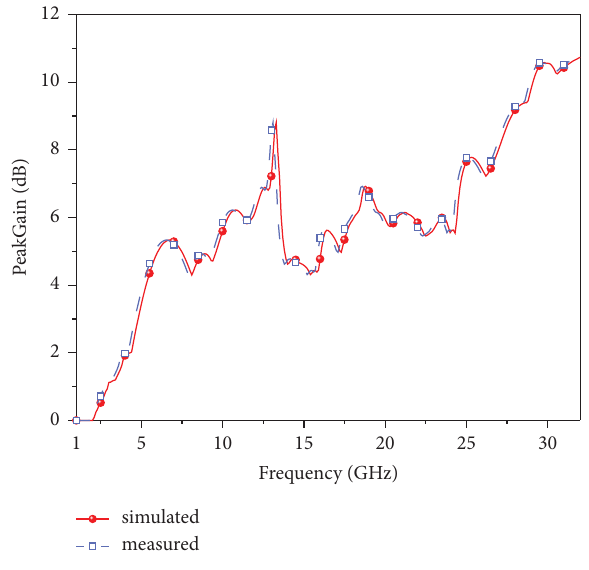
Figure 14: Peak gain of the